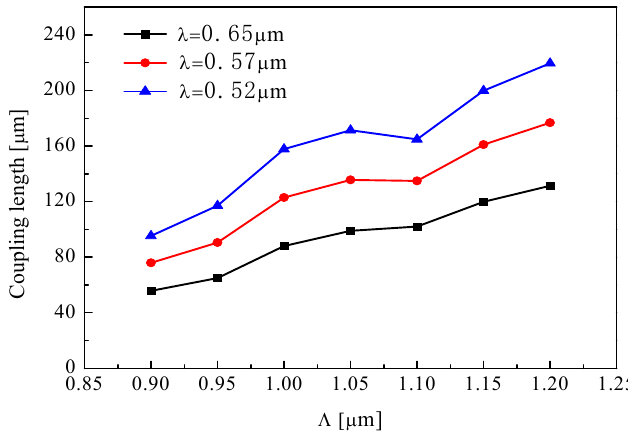
Figure 4. Period Λ dependence of the coupling length for different wavelength.